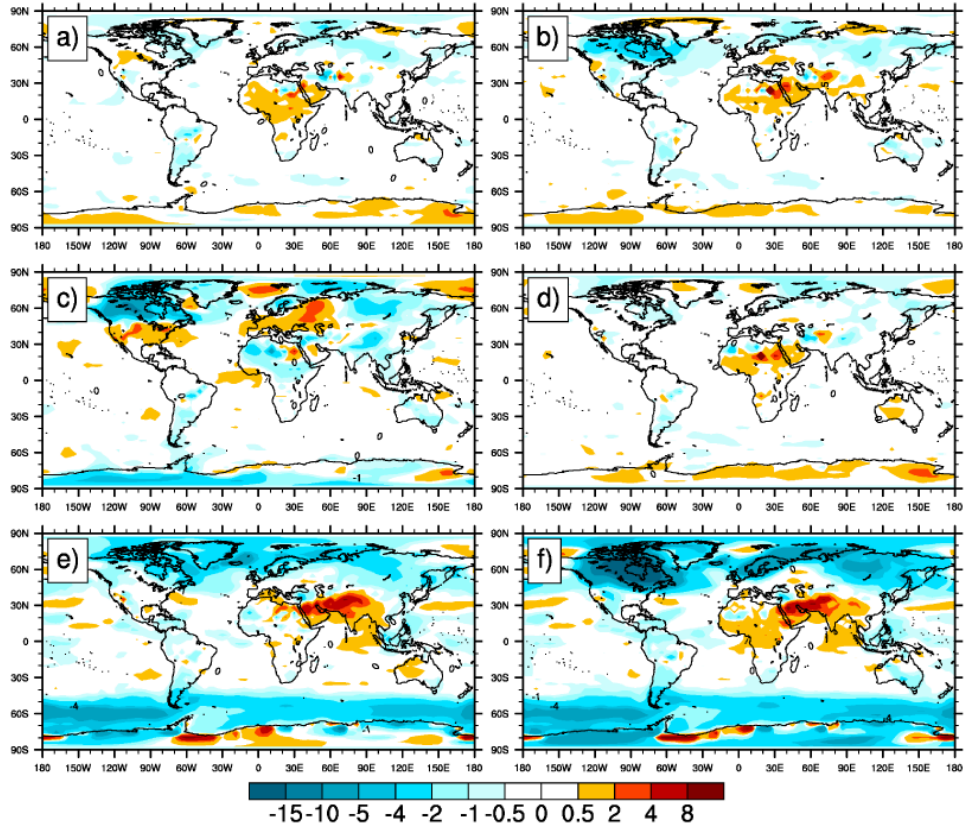
Fig. 10. As Fig. 9, but for JJA